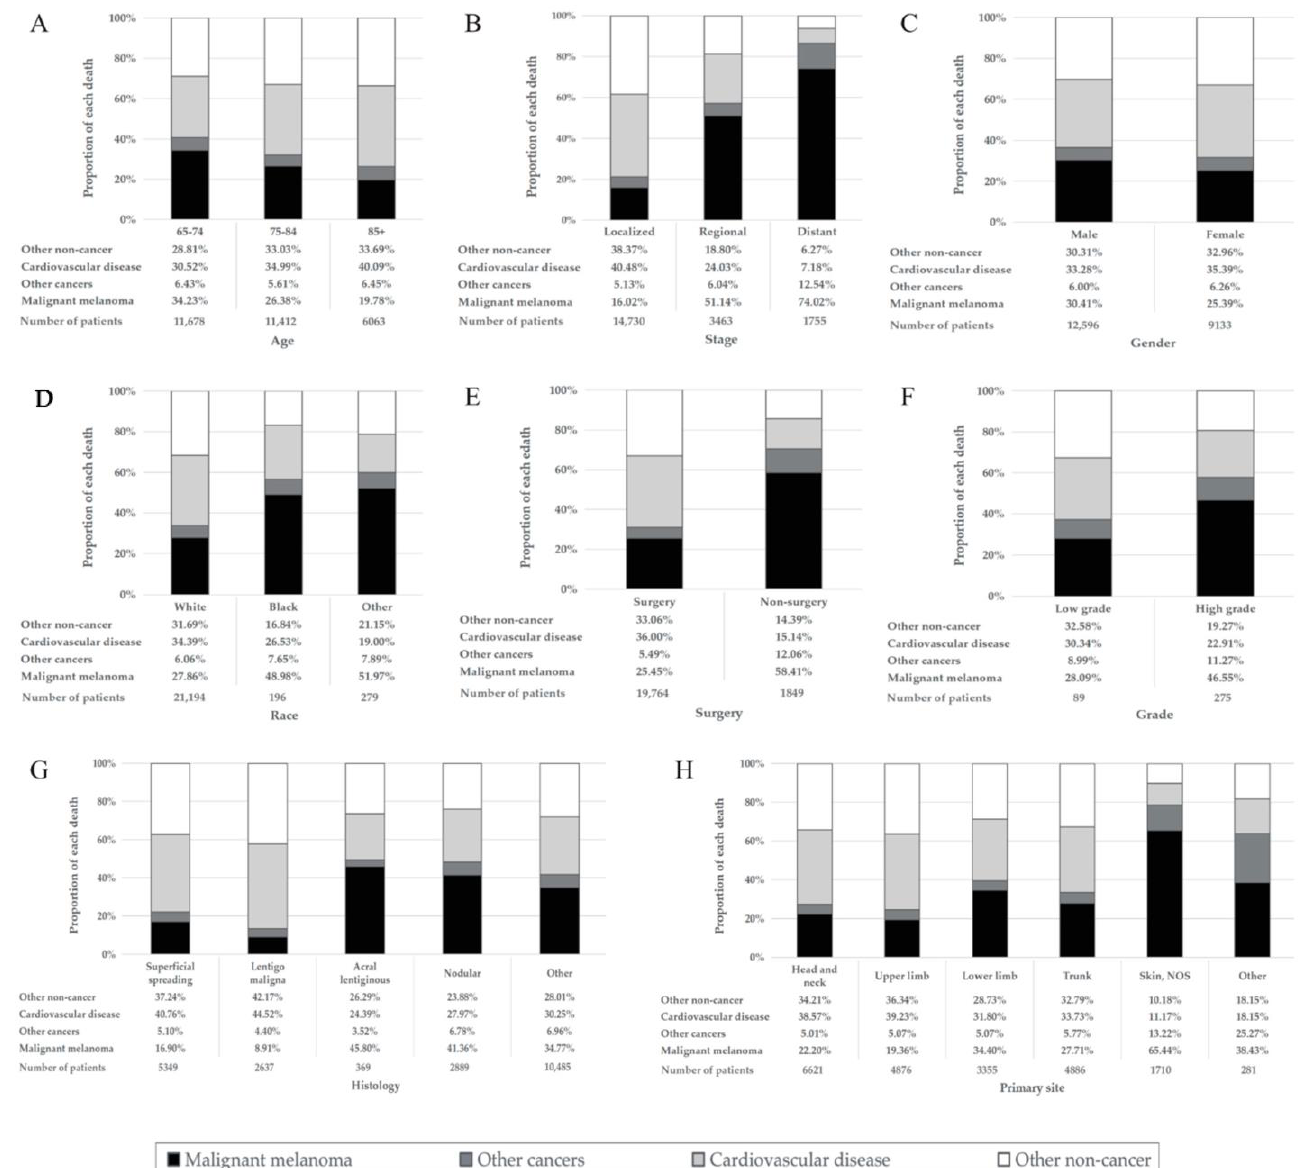
Figure 1. Percentage of each cause of death in different malignant melanoma patient groups. The height of the four differently colored stacked bars shows the different proportions of deaths from malignant melanoma (black), other cancer death (dark gray), cardiovascular disease (light gray) and other noncancer death (white), respectively. ( A ) Patients by different age at diagnosis. ( B ) Patients at different stages. ( C ) Patients of different genders. ( D ) Patients of different races. ( E ) Patients with/without surgical treatment. ( F ) Patients with different grades. ( G ) Patients with different histologies. ( H ) Patients with different primary sites. Abbreviation: NOS, not otherwise specified.